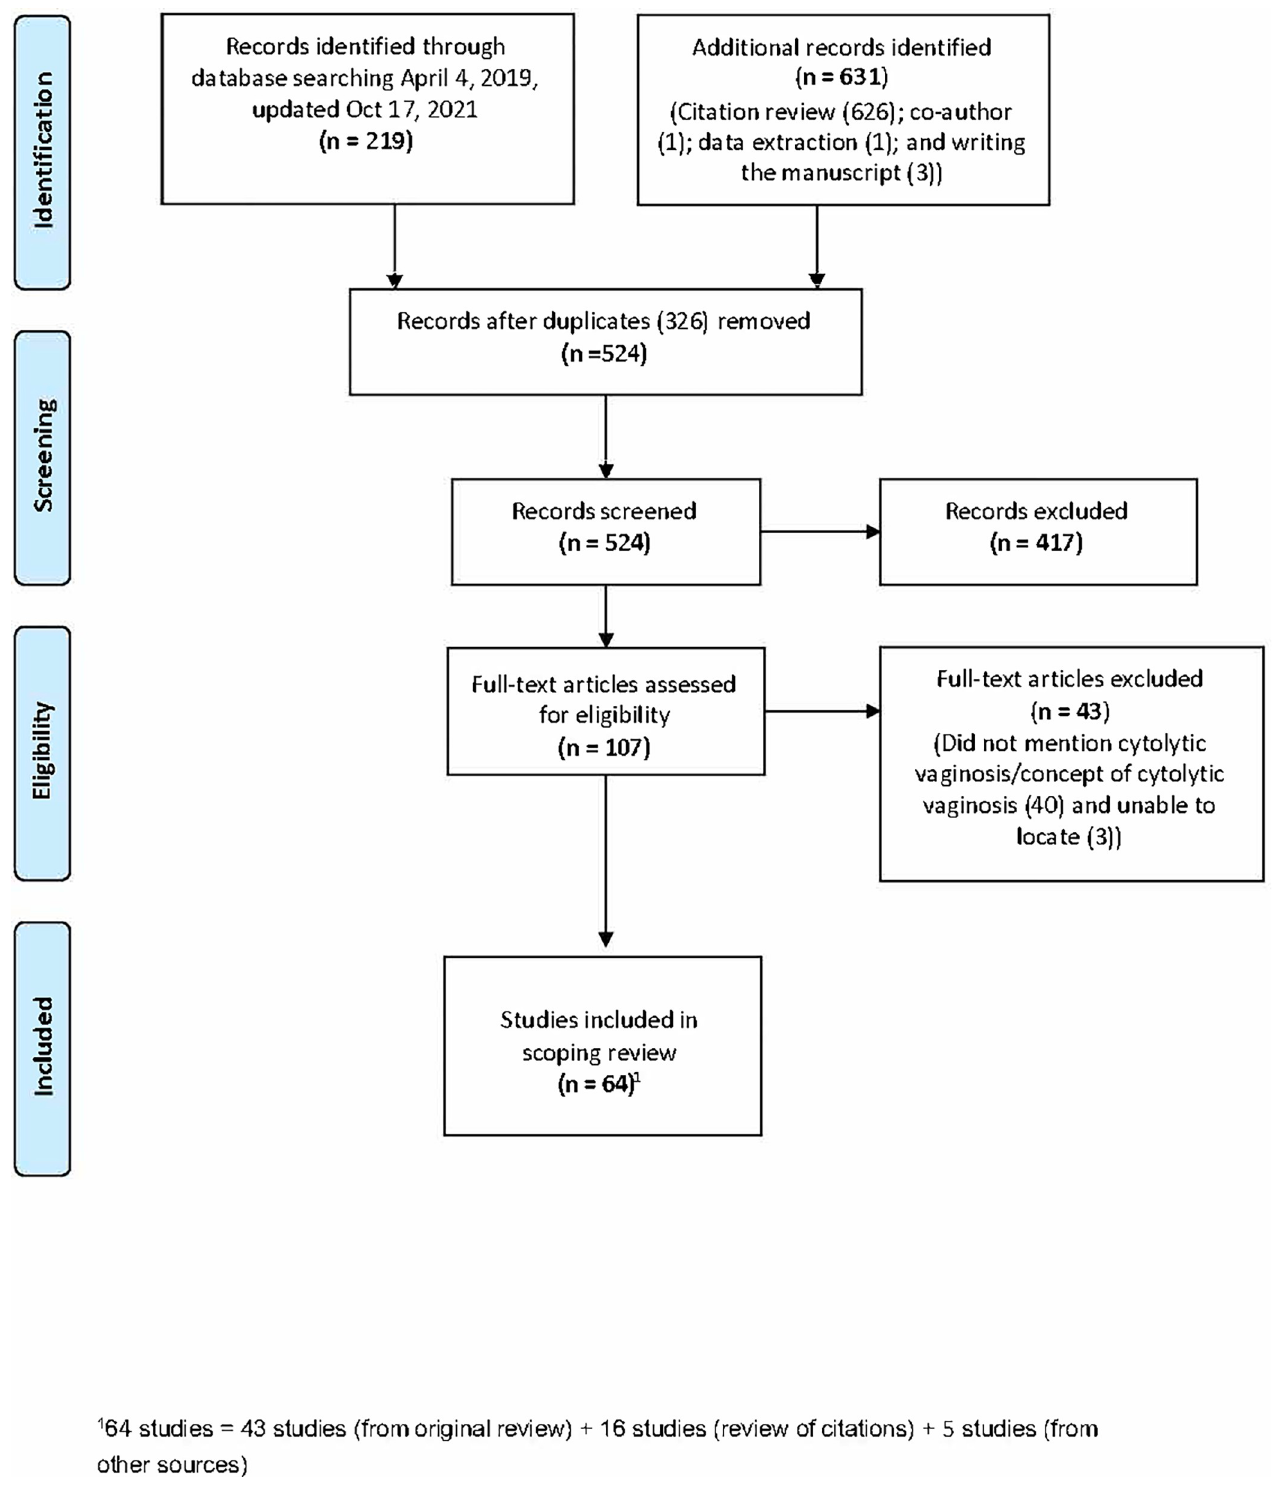
Fig 1. PRISMA flow diagram.